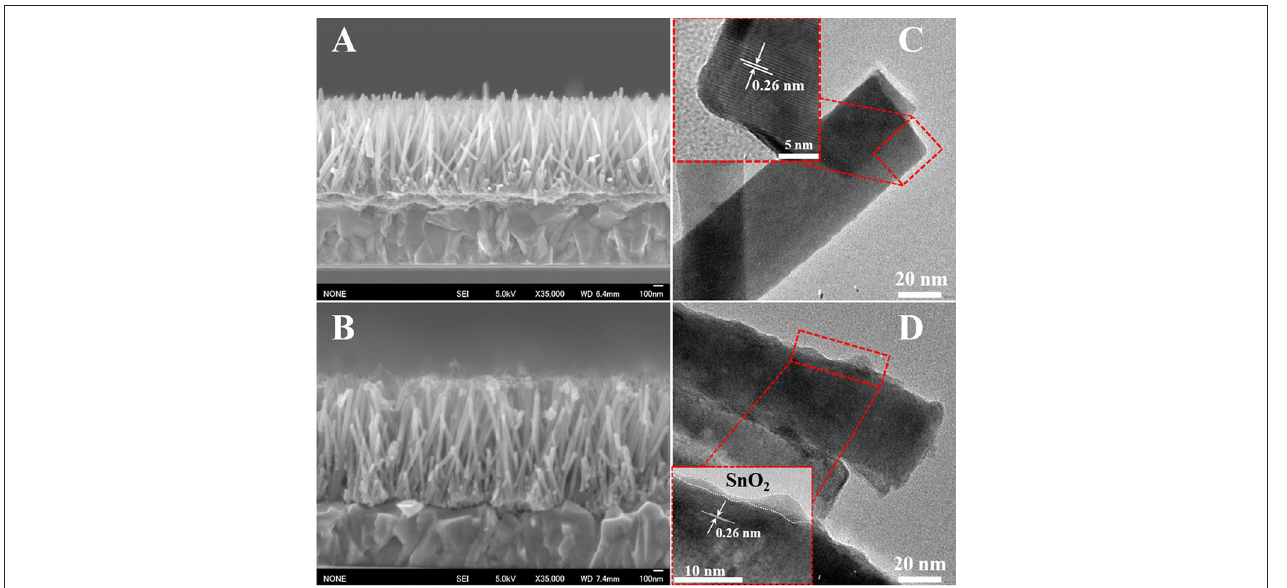
FIGURE 1 | The cross-sectional FESEM images of bare ZnO NWs (A) and ZnO@SnO 2 NWs (B) . TEM images of bare ZnO NWs (C) and ZnO@SnO 2 NWs (D) . The inset photograph is the HR-TEM image of NWs. TEM image of ZnO@SnO 2 NWs shows the surface of ZnO NWs covered with SnO 2 layer.